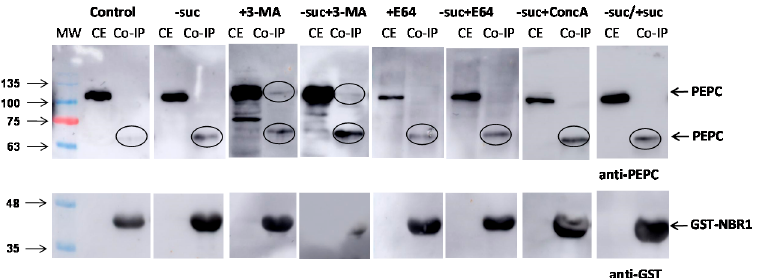
Figure 8. Co-immunoprecipitation of PEPC with GST-NBR1 in N. benthamiana cells. Crude extracts were prepared from five-day-old N. benthamiana cell cultures and aliquots containing 50 µg of protein were used in the pull-down experiments. When indicated, cells were kept without sucrose (-suc), or 5 d without sucrose and then 2 d with sucrose ( − suc/+suc). 3-MA was added at 2.5 mM (5 d), along with ConcA at 1 µM (16 h), and E64 at 10 µM (16 h). The other conditions are the same as in Figure 6. CE, crude extracts; Co-IP, co-precipitated proteins.